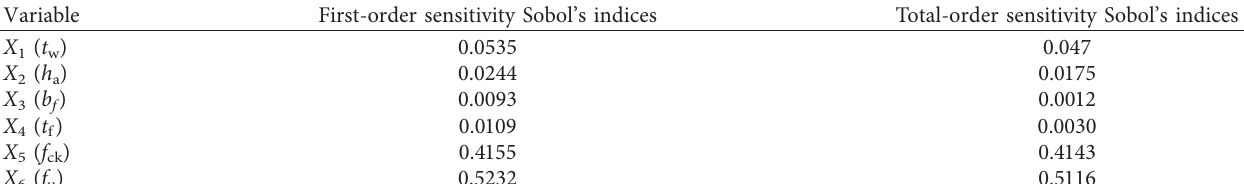
Table 8: Mean estimation with 200,000 Monte Carlo samples of the first and total Sobol’s indices for the 10-year corroded SCC beams.